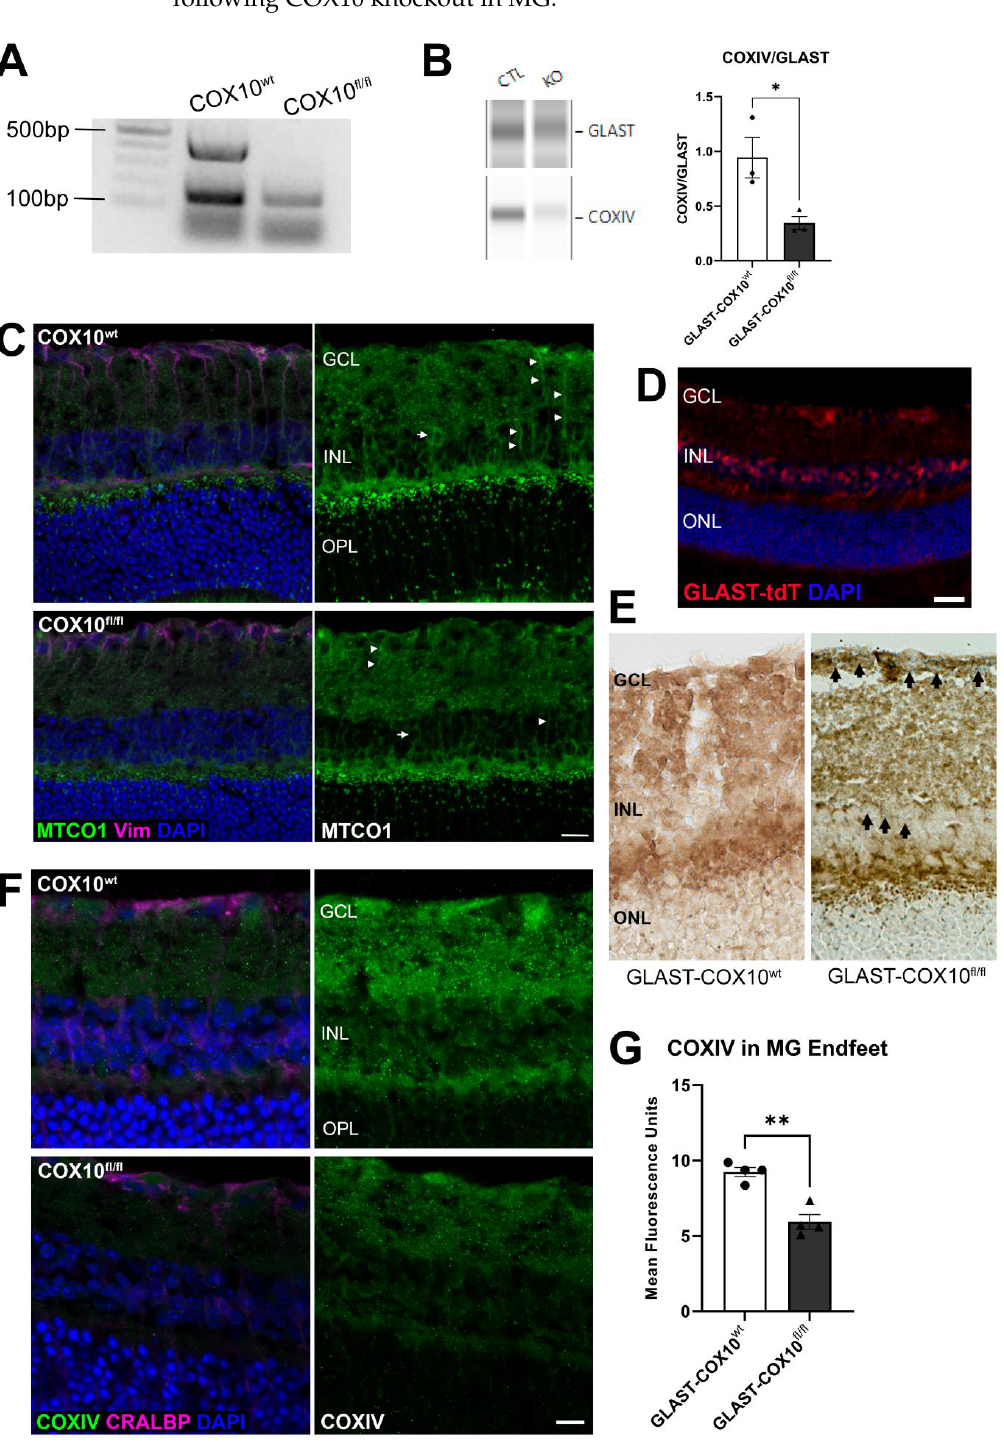
Figure 1. Recombination and Deletion of COX10. ( A ) Confirmation of Cox10 gene recombination in conditional knockout retinas at 3 months of age. An approximately 500 bp band indicates loss of exon 6 of the Cox10 gene. ( B ) Capillary electrophoresis lanes showing COXIV and GLAST protein levels in primary MG cell lysates from control and GLAST-COX10 fl/fl mice. Right: Quantitative anal- ysis of protein levels shows a statistically significant decrease in COXIV in MG from GLAST-